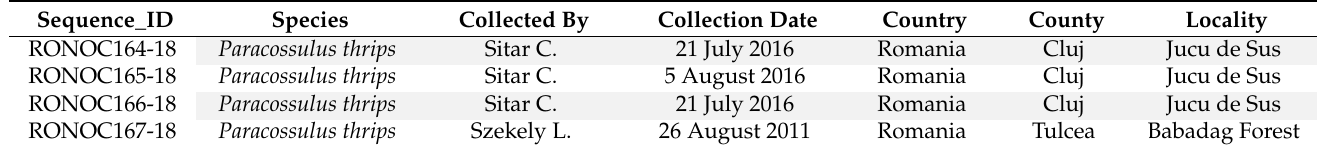
Table 2. The details of specimens used for DNA